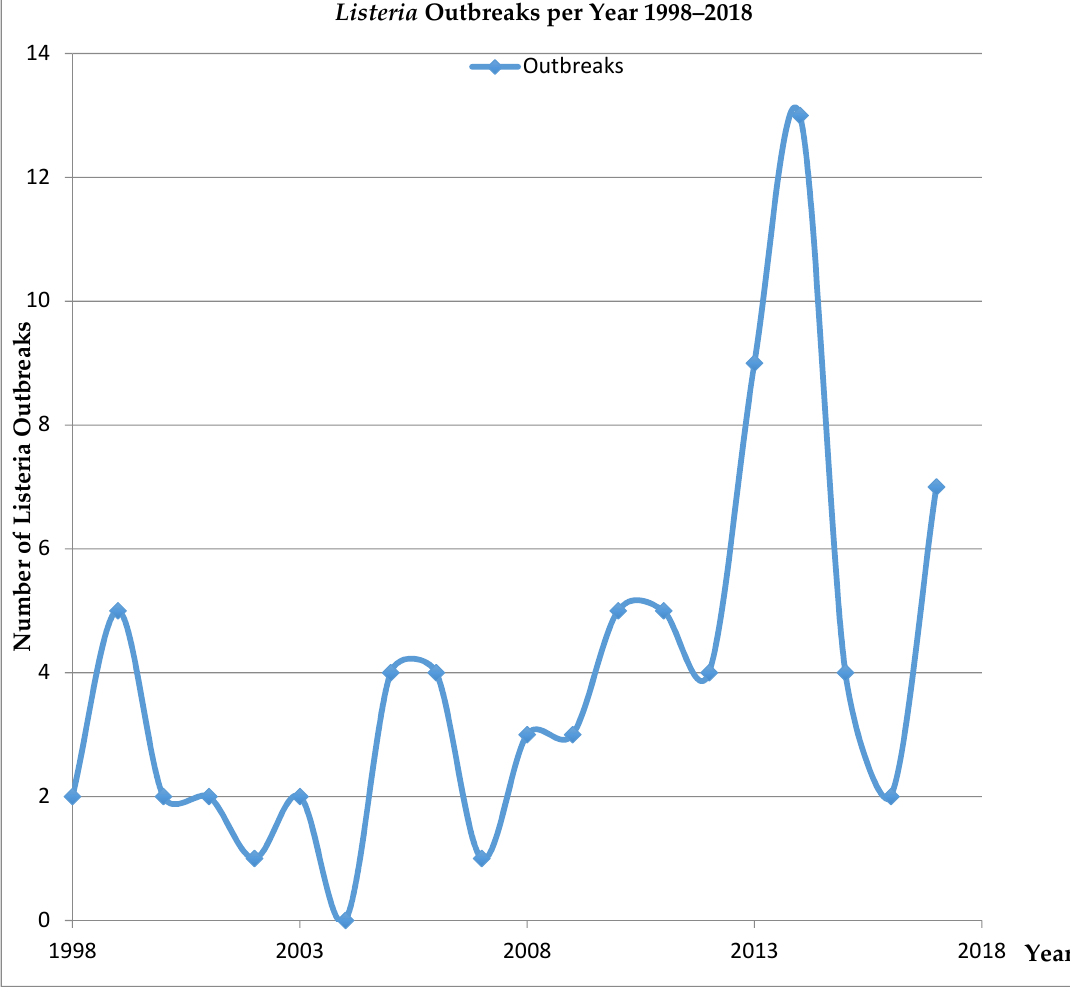
Figure 1. Listeria Outbreaks in the U.S. 1998–2018*. * From the NORS Dashboard Available at https://wwwn.cdc.gov/norsdashboard/. (Accessed on 9 May 2019).